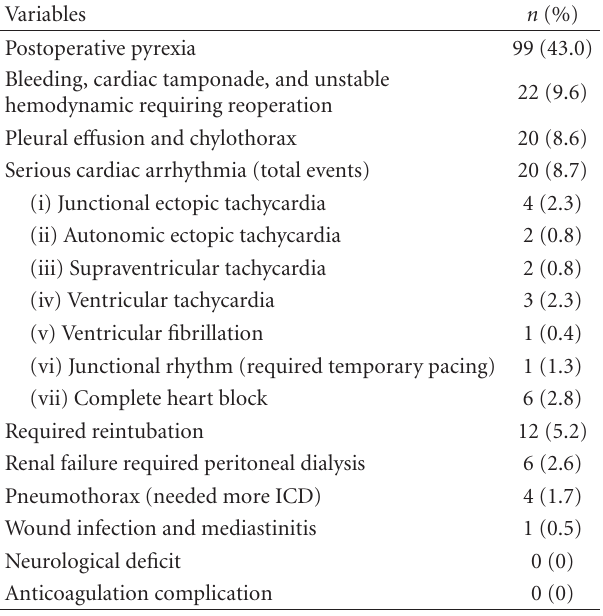
Table 7: Major postoperative complications and morbidities ( n = 230).